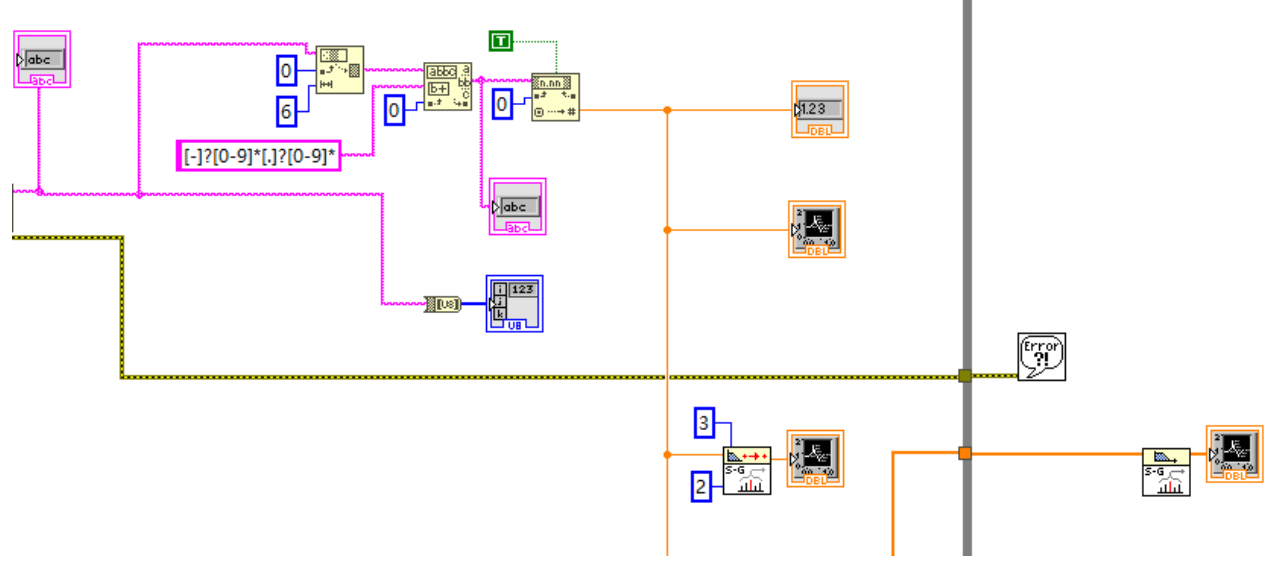
Figure 3. Implementation of Savitsky–Golay filtering algorithm in Labview.